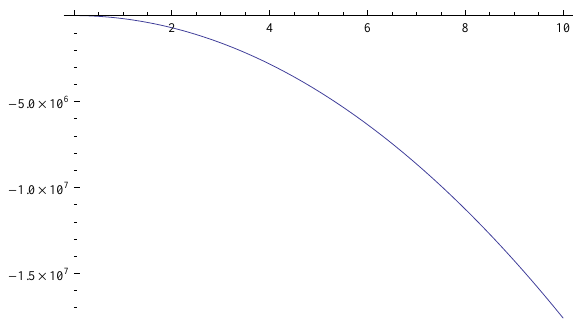
Figure 2. Graph of f 2 ( x )